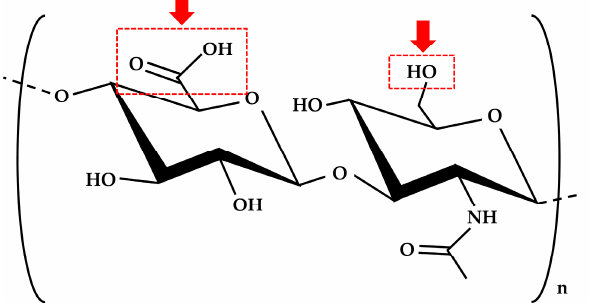
Figure 12. Two major cross-linking points of HLA, such as -COOH and -OH functional groups.